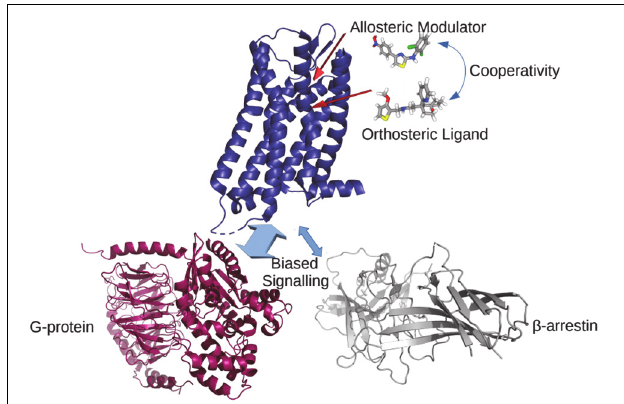
FIGURE 2 | A cartoon representation of the effects of different ligands on a GPCR. The cooperativity between allosteric and orthosteric ligands can shift their affinities for the receptor, and/or bias the GPCR coupling to a particular intracellular